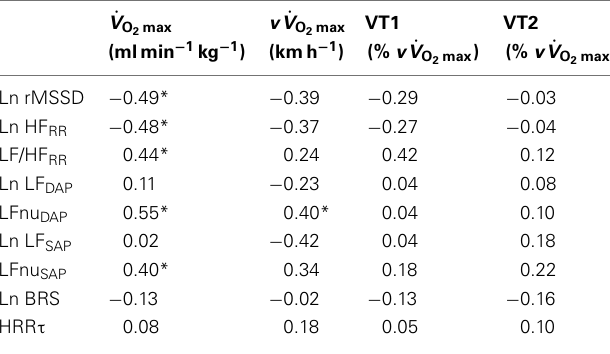
Table 7 | Correlations between pre-exercise autonomic parameters and cardiorespiratory fitness and running performance in highly trained young soccer